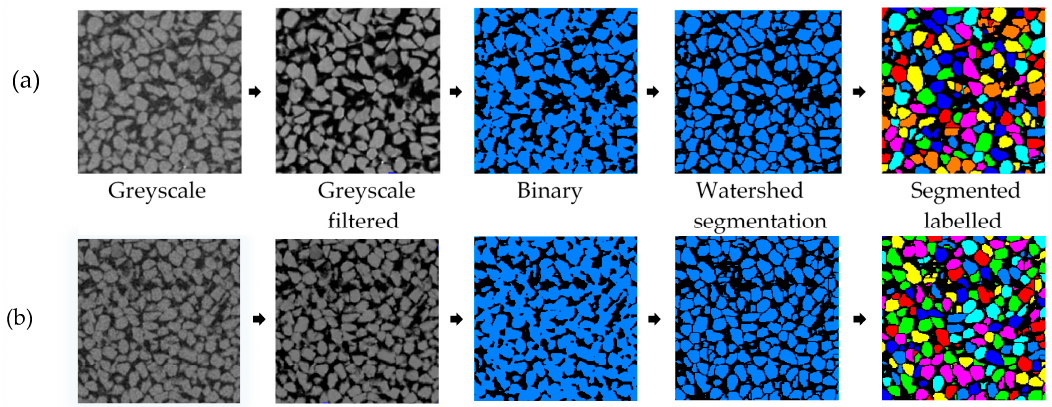
Figure 9. Examples of image processing depicting particle separation and identification for ( a ) no load; and ( b ) 14.1 MPa.